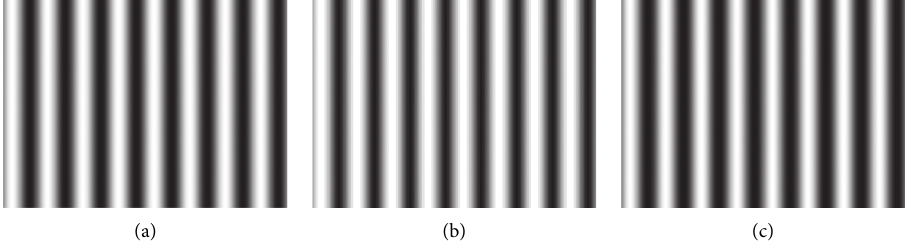
Figure 3: The original precoding fringe and actual fringe. (a) Original gamma � 0.80. (b) Precoding gamma � 0.60. (c) Precoding gamma �